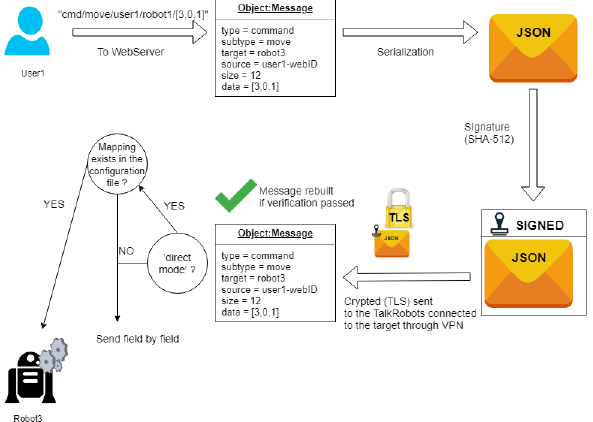
Figure 5. Command direct